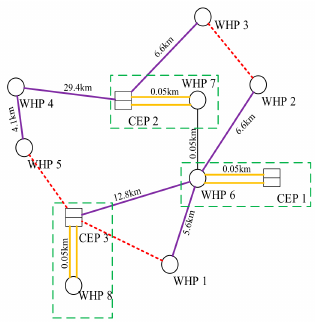
Figure 11. Ring network diagram, for